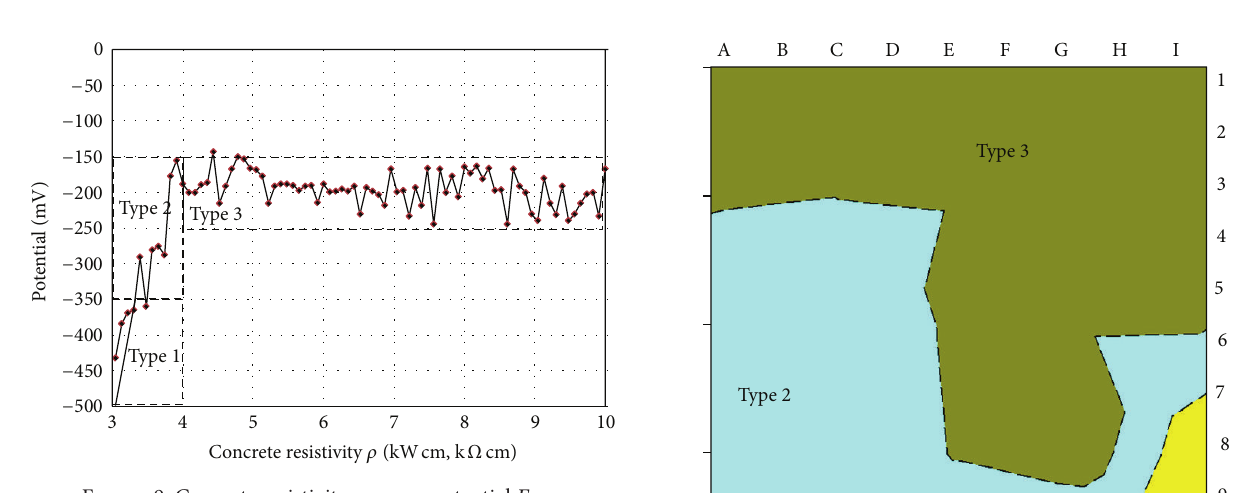
and (b) concrete resistivity 𝜌 . corr